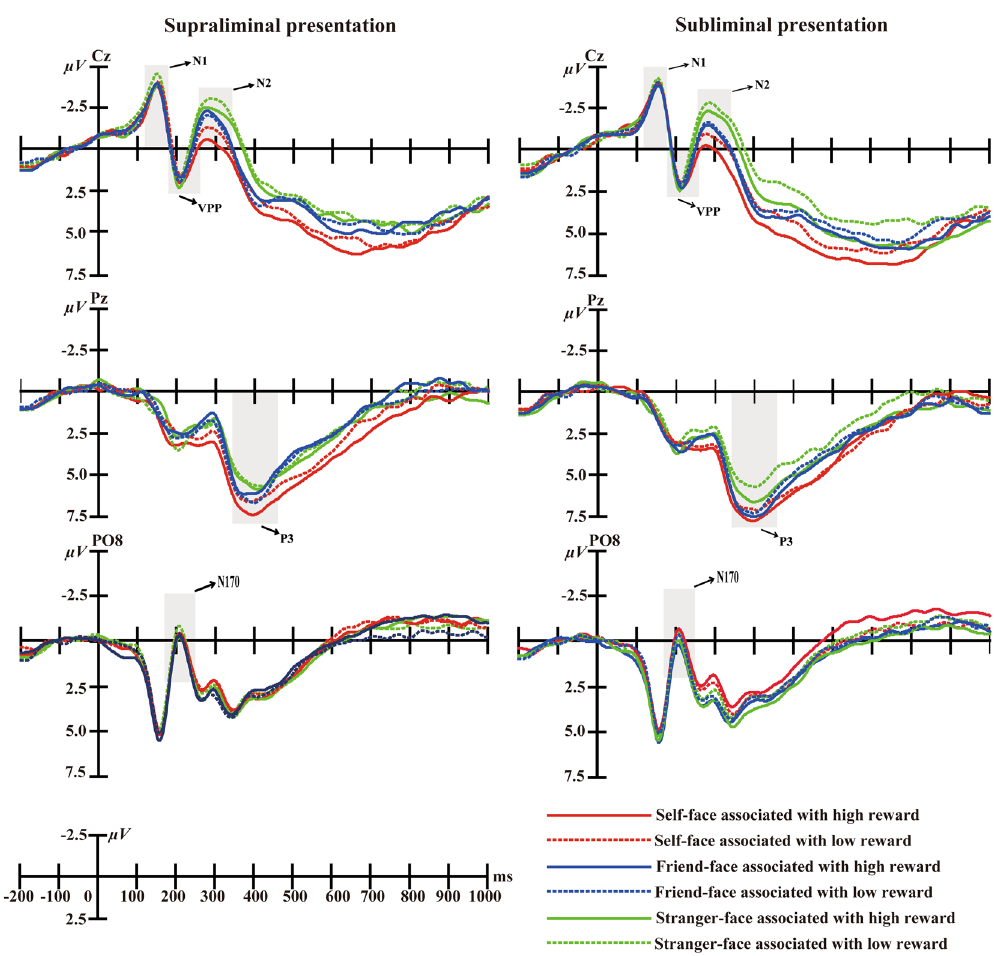
Figure 1. The sequence of events in an experimental trial (acknowledge the copyright holder Haonan Yin, Meimei Li, Yaling Huang and Juan